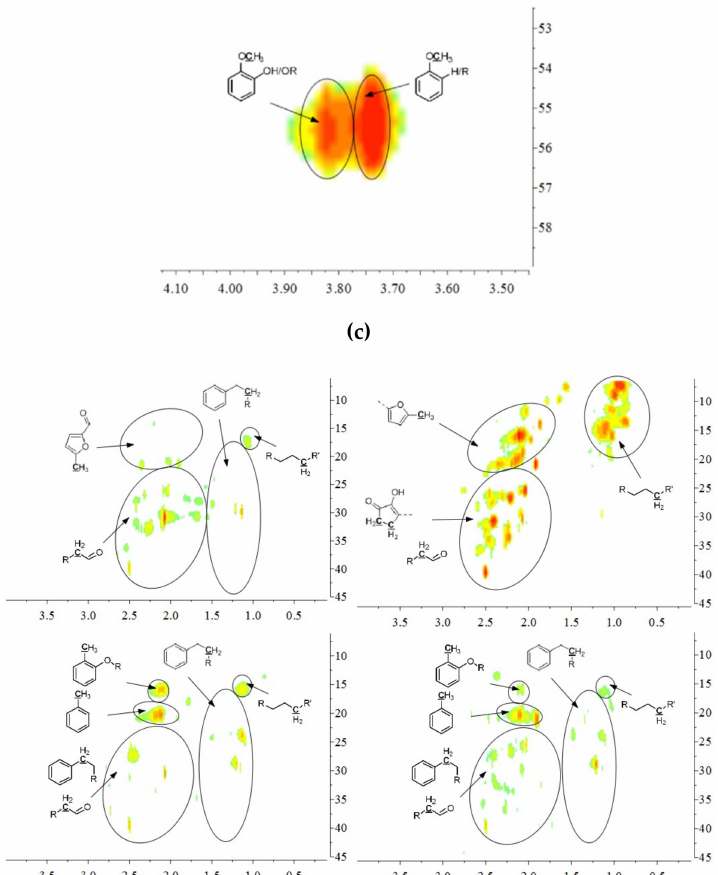
Figure 2. ( a ) Aromatic C–H bonds in HSQC-NMR spectra for the pyrolysis oils produced from cellulose, hemicellulose, lignin, and tannin (from top left to bottom right) at 600 ◦ C. ( b ) Levoglucosan and a similar dehydrated monosaccharide in HSQC-NMR spectra for the pyrolysis oils produced from cellulose and hemicellulose (from left to right) at 600 ◦ C. As expected, there would be no similar components in lignin and tannin pyrolysis oils, if samples were purified. ( c ) Methoxyl groups in HSQC-NMR spectra for the pyrolysis oils produced from lignin at 600 ◦ C. As expected, methoxyl groups were only present in lignin pyrolysis oil, if samples were purified. ( d ) Aliphatic C–H bonds in HSQC-NMR spectra for the pyrolysis oils produced from cellulose, hemicellulose, lignin, and tannin (from top left to bottom right) at 600 ◦